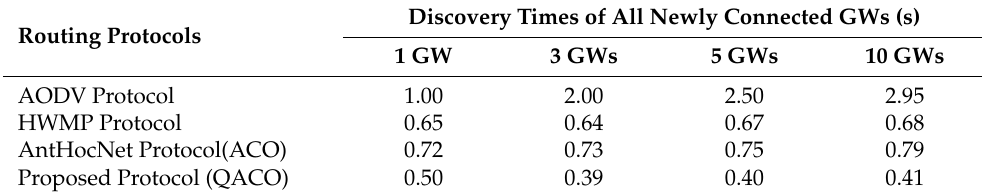
Table 4. Time to discover new GWs for distinct routing techniques.